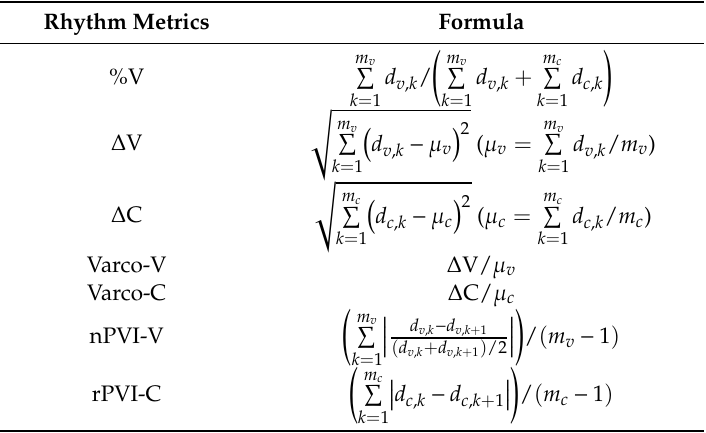
Table 1. Formulas of rhythm metrics. nPVI: normalized Pairwise Variability Index, rPVI-C: Raw Pairwise Variability Index.